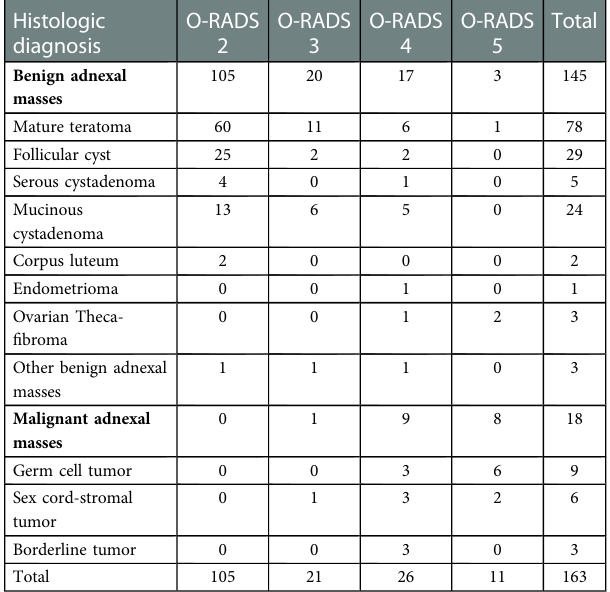
TABLE 3 O-RADS classi fi cation and histological diagnosis of 163 ovarian masses. Histologic diagnosis